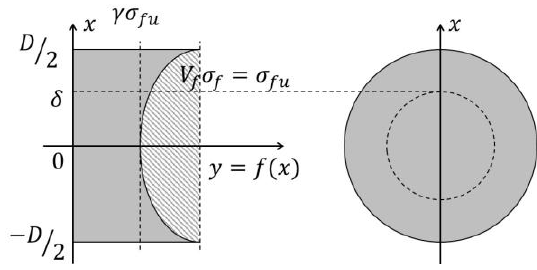
Figure 4. Assumed stress distribution on transversally projected section.